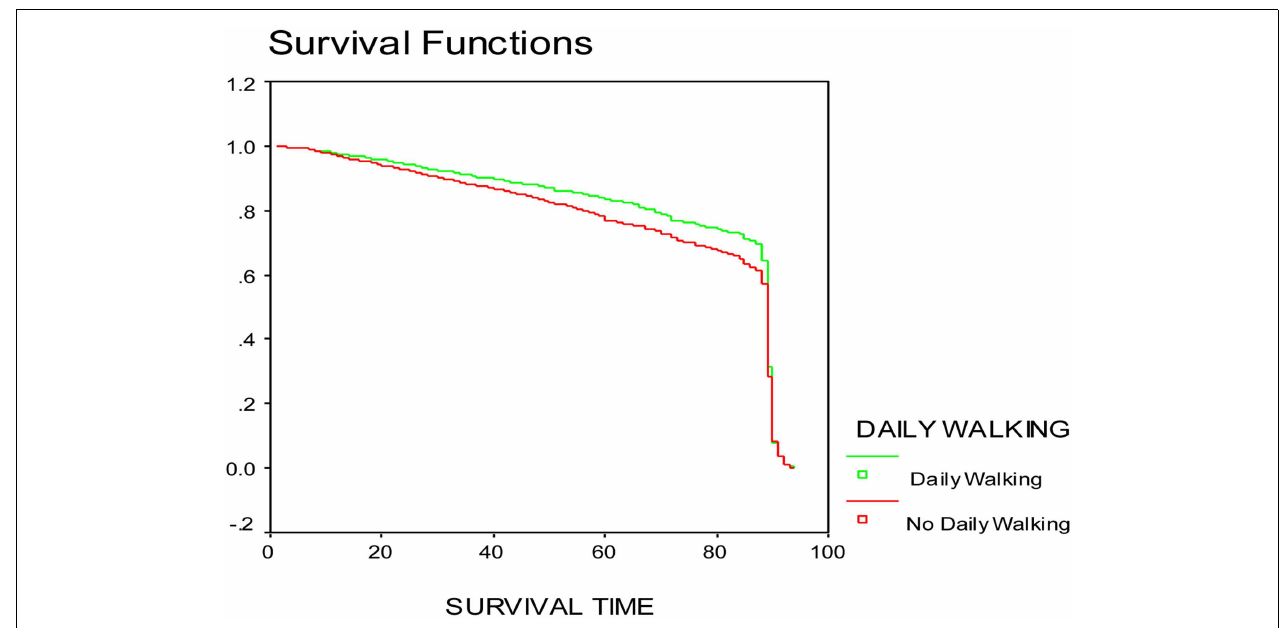
FIGURE 1 | Kaplan Meier survival function estimate for daily walking variable